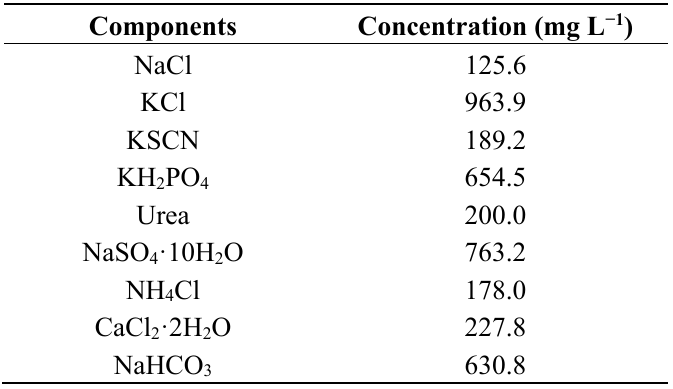
Table 2. Composition of the artificial saliva (SAGF